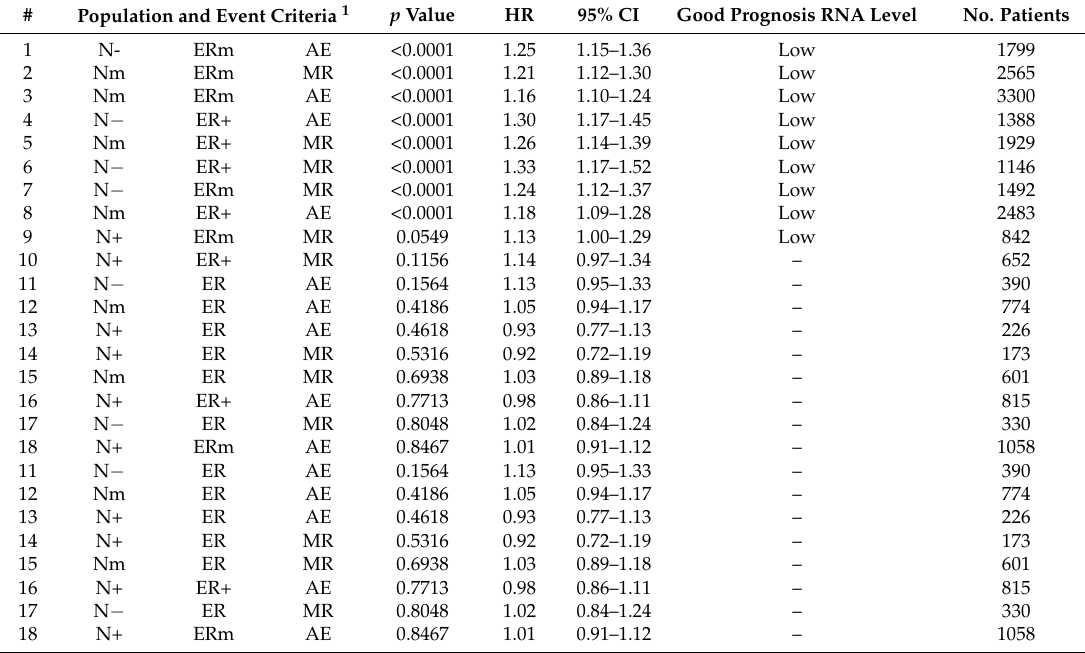
Table 1. AGO2 expression is inversely related to breast cancer clinical prognosis in ER α + tumors but not ER α −